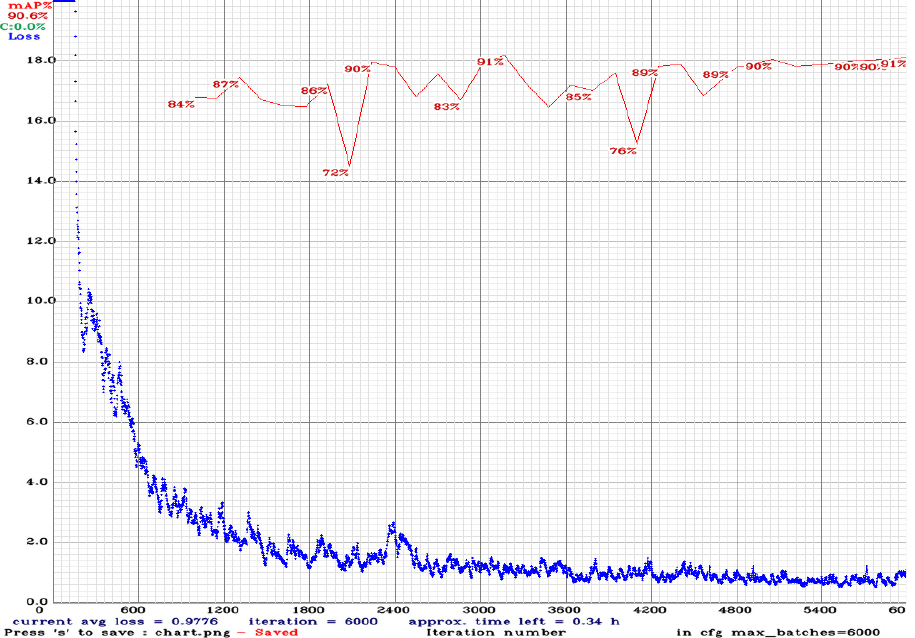
Figure 15. Loss and accuracy graph of the full-size YOLOv4. Table 4. Performance